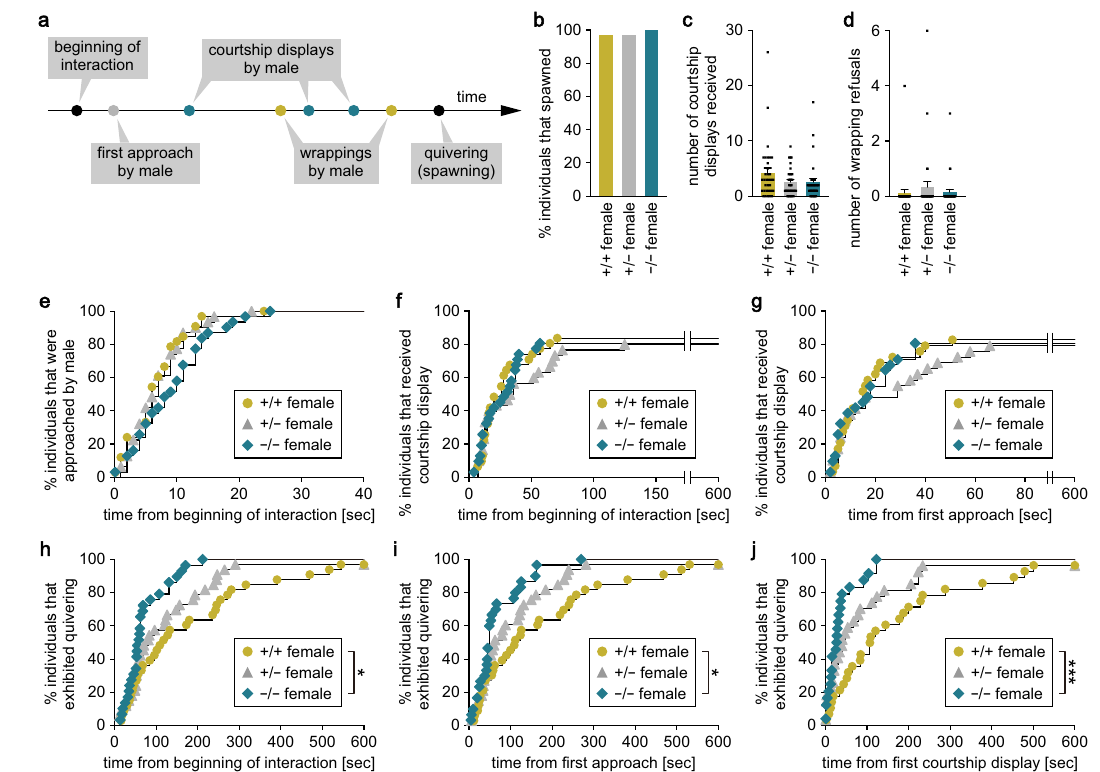
Fig. 5 ptger4b -de fi cient females exhibit increased sexual receptivity. ptger4b + / + , ptger4b + / − , and ptger4b − / − females of the Δ 17 line were tested for mating behavior ( n = 33 for each genotype). a Schematic representation of the typical sequence of mating behavior in medaka. b Percentage of individuals that spawned during the test period (10 min). Number of courtship displays received ( c ) and wrapping refusals ( d ). Latency from the beginning of interaction to the fi rst approach ( e ) and courtship display ( f ). g Latency from the fi rst approach to the fi rst courtship display. Latency from the beginning of interaction ( h ), fi rst approach ( i ), and fi rst courtship display ( j ) to quivering. Quantitative data were expressed as means with error bars representing standard error of the mean ( c , d ). Behavioral time-series data were expressed as Kaplan – Meier plots ( e – j ). Statistical differences were assessed by Fisher ’